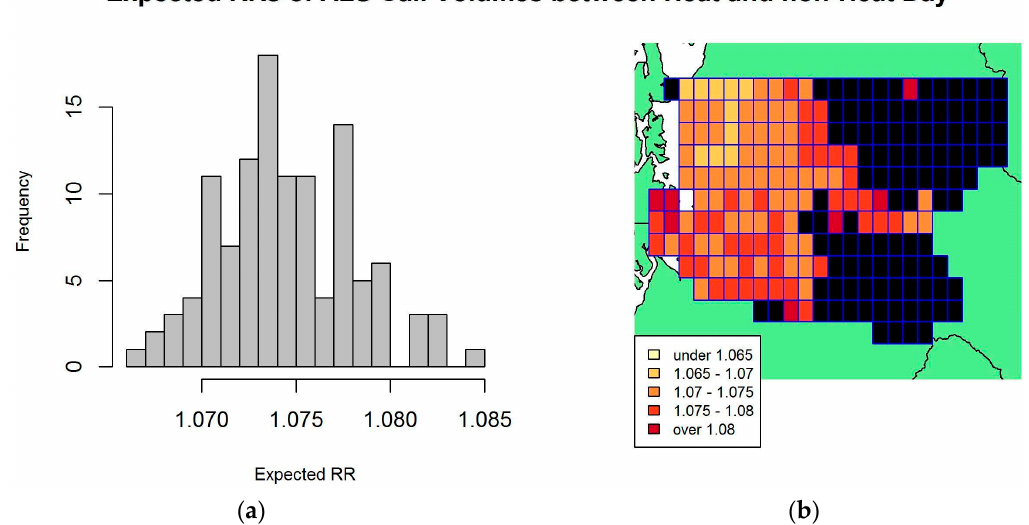
Figure 4. Relative rate (RR) analysis on ALS data: ( a ) Histogram of expected RRs of ALS call volumes between heat and non-heat day, defined by humidex threshold of 33.5 °C; ( b ) King County, Washington’s Grid map of expected RRs for ALS data, where black indicates grid cells without call data or too few call data to be included in the analysis. Each grid cell has size of 4 km by 7.5 km.